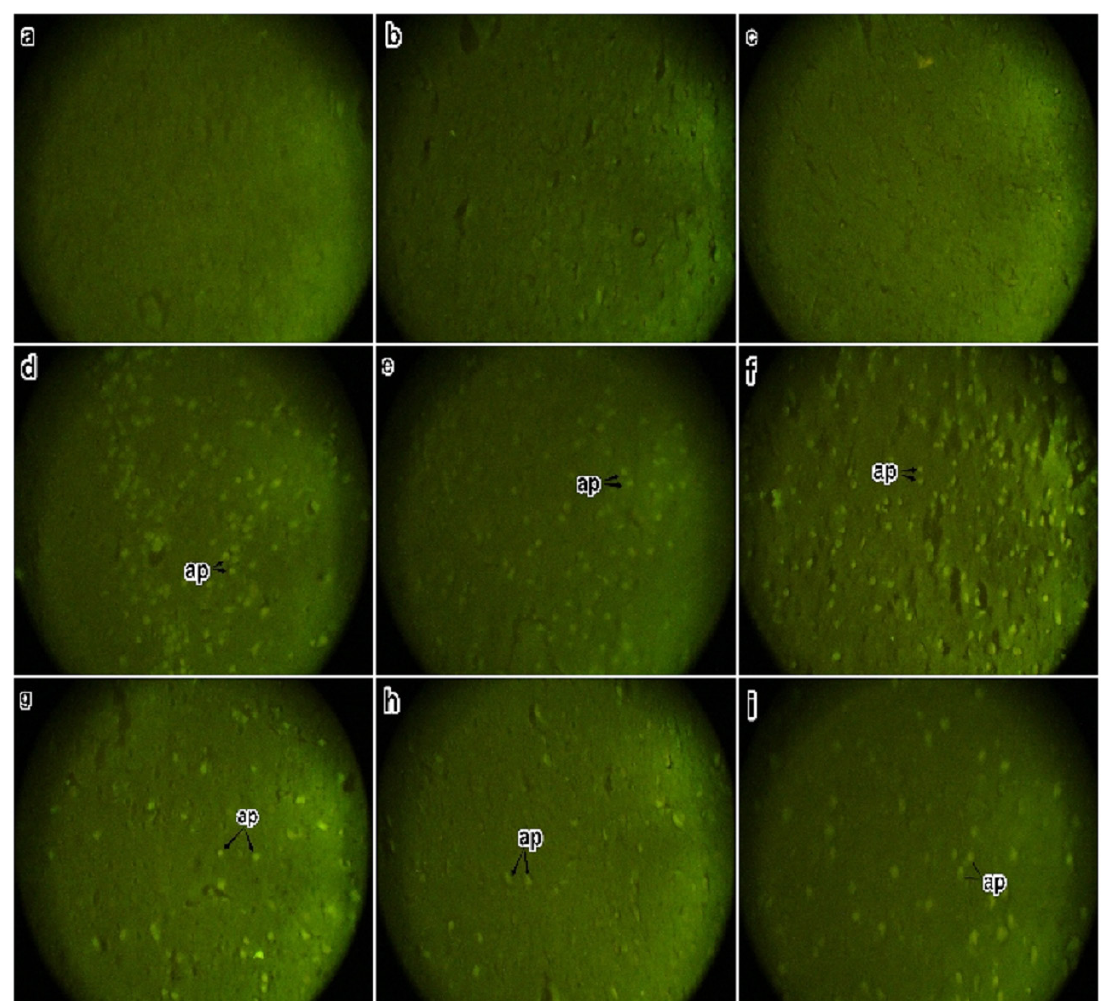
FIGURE S2 - Thioflavin S staining of amyloid plaques in the hippocampus CA1 region. a (Ctr); b (S+W); c (R); d (Aβ); e (Aβ+W); f (Aβ+R), g (Aβ+T+100), h (Aβ+P+100), and i (Aβ+R+100). Please refer to the Methods and Materials section for the groups’ definitions. ap: amyloid plaques;